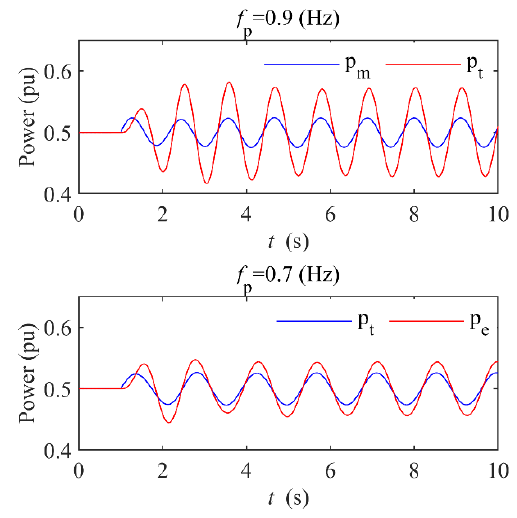
Figure 2. p t and p e with different f p s